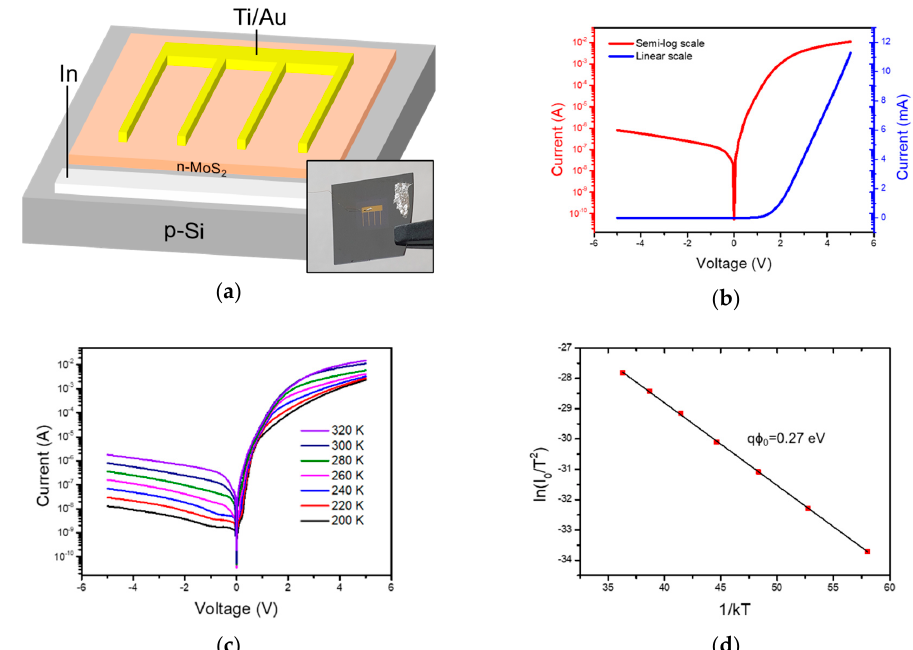
Figure 3. ( a ) Schematic diagram of the n-MoS 2 /p-Si heterojunction diode. The inset in ( a ) shows photograph of the heterojunction diode. ( b ) Electrical characterization of n-MoS 2 /p-Si heterojunction on semi-log scale (red) and linear scale (blue). ( c ) Temperature dependent I-V measurement in semi-log scale. ( d ) Richardson plot from the I-V measurement. The barrier height was calculated to be 0.27 eV.